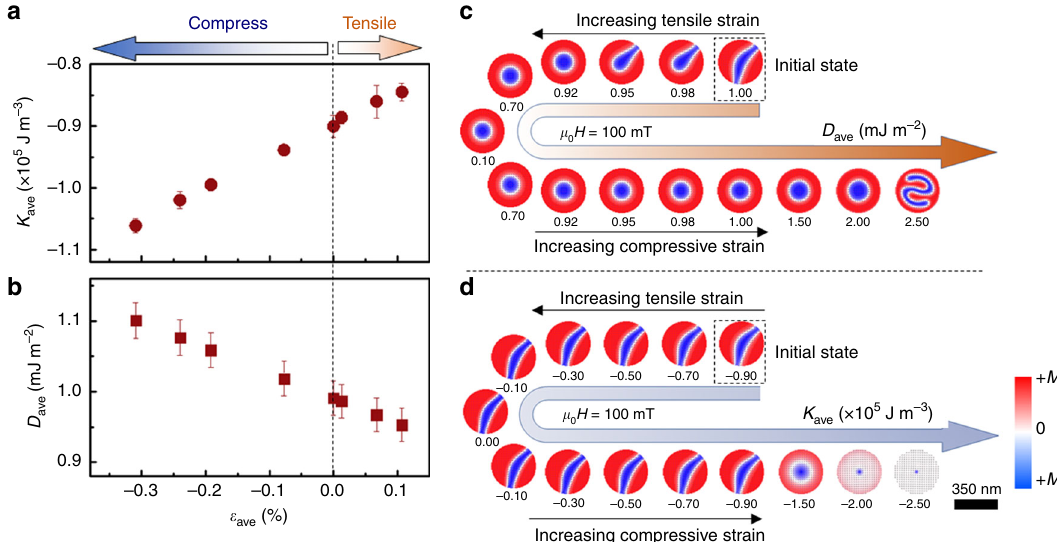
Fig. 4 Simulated variation of D ave and K ave on magnetic domain evolution. Dependence of the experimentally established values of a K ave (red circles) and b D ave (red squares) on ε ave on the d ~ 350 nm [Pt/Co/Ta] 12 nano-dot. The positive value of ε ave represents the tensile strain, while the negative value signi fi es the compressive strain. The dashed line represents the boundary between the tensile strain and the compressive strain. The black lines in a and b represent the fi tting lines by using linear equations. The error margin of K ave at different E is added by measuring two different samples and the error margin of D ave at different E is added by fi tting different ε ave – D ave curves for both the continuous thin fi lm and d ~850 nm nano-dot. c Simulations of the in fl uence of D ave on the magnetic domain evolution. d Simulations of the variation of K ave on the magnetic domain evolution. Notably, when one magnetic parameter varies in the simulations, the other magnetic parameters are fi xed. An external magnetic fi eld of 100 mT is applied in the simulations, and the magnetic domain enclosed by the black dashed boxes in c , d represent the initial states in the domain evolution process. The magnetization along the z -axis ( M z ) is represented by regions in red ( + M z ) and blue ( − M z ). The scale bar is 350